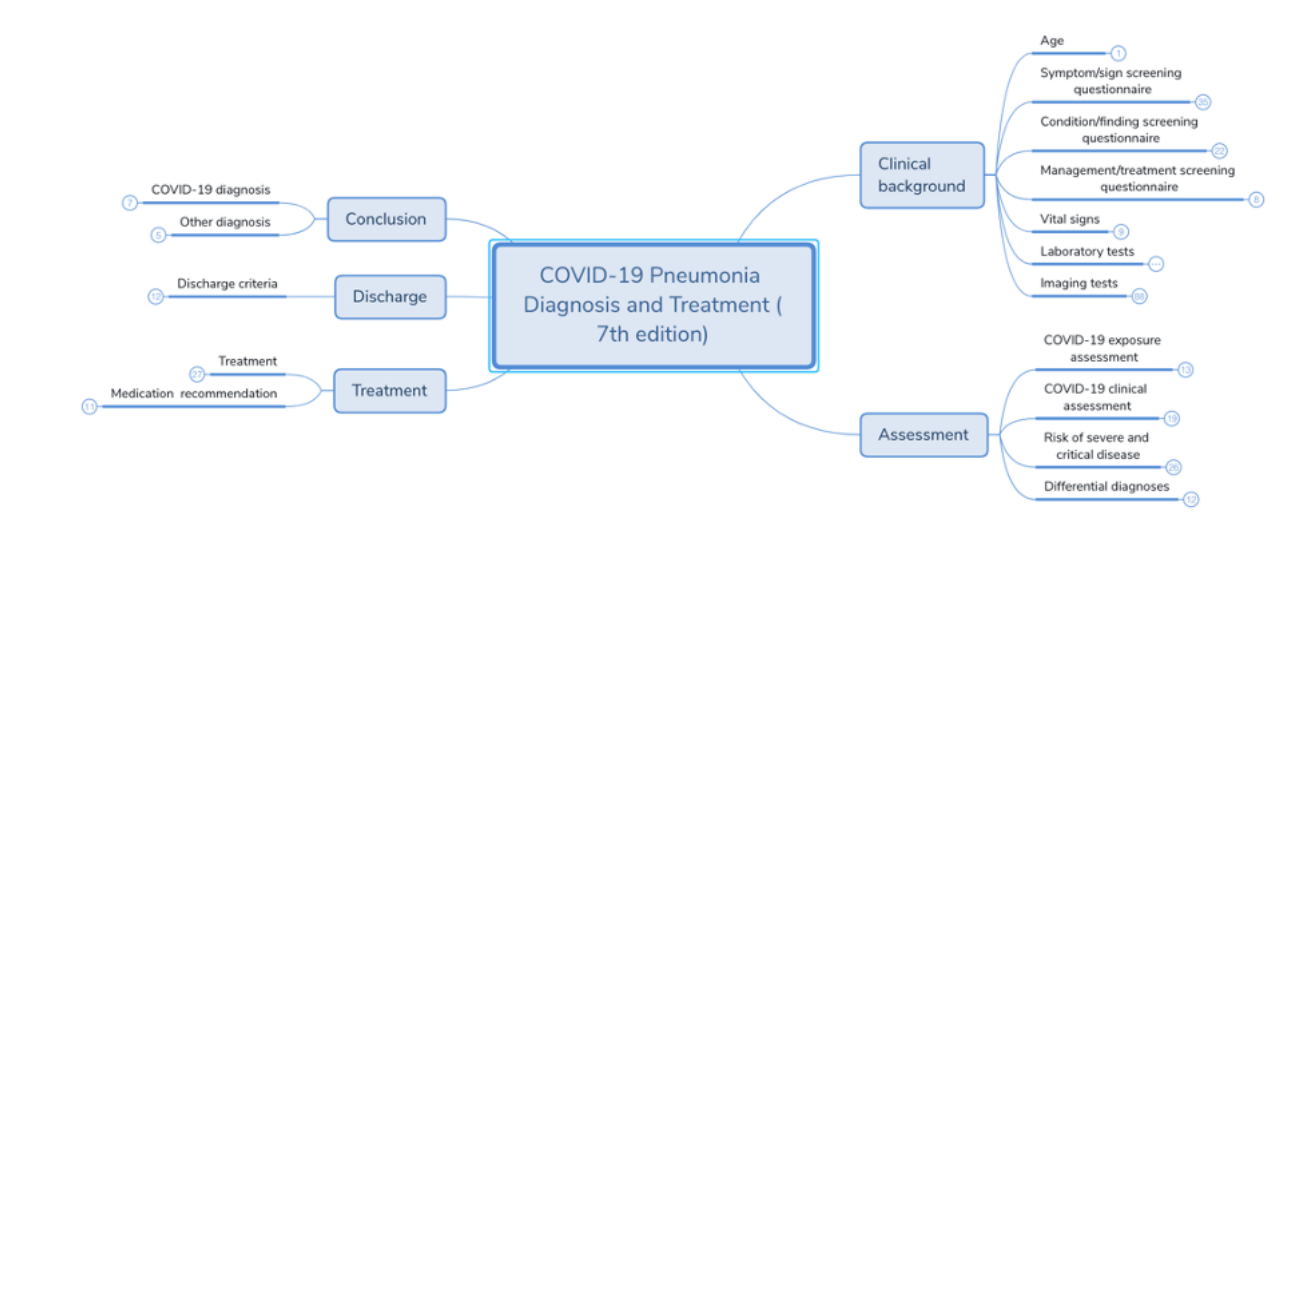
Figure 3. Domain concepts about COVID-19. COVID-19: coronavirus